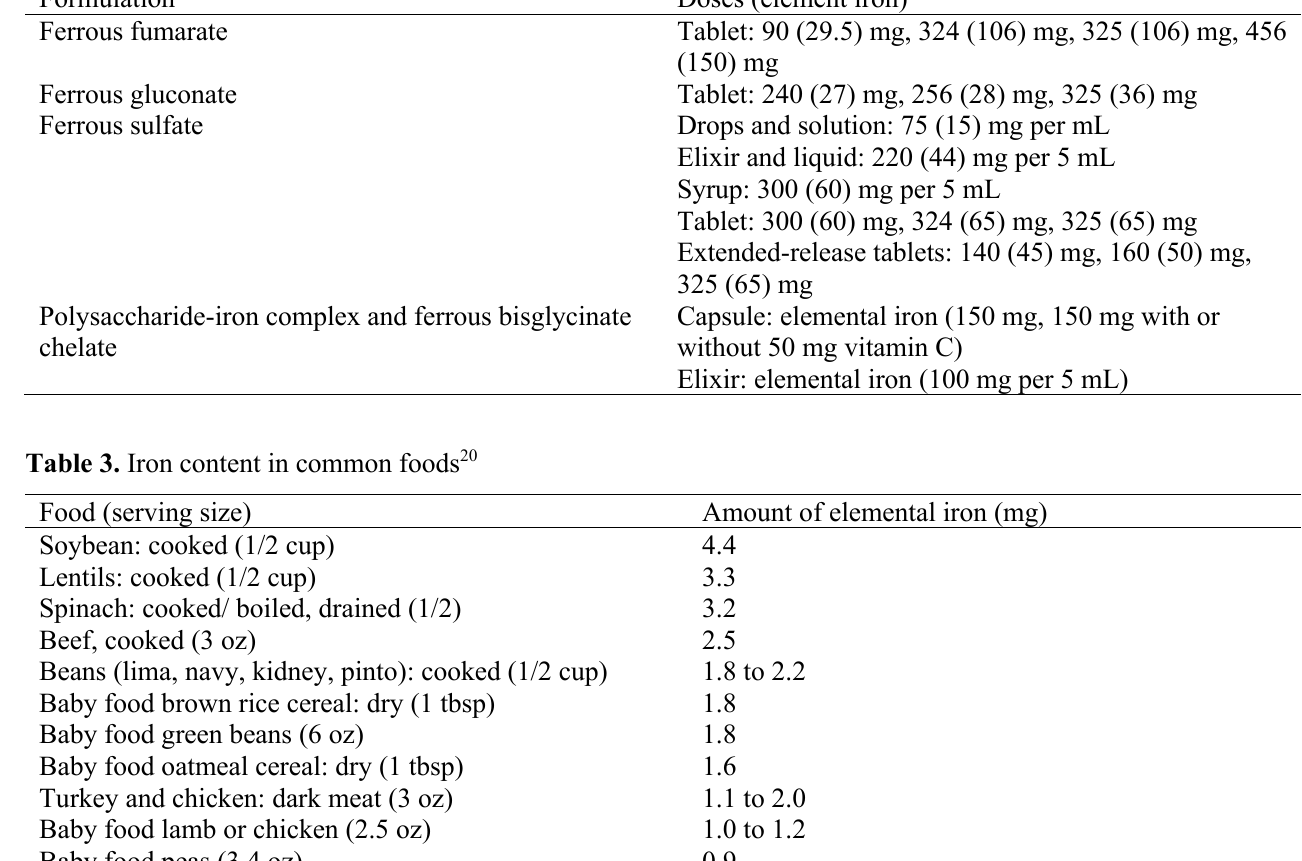
Table 2. Oral iron formulations and doses 20 Formulation